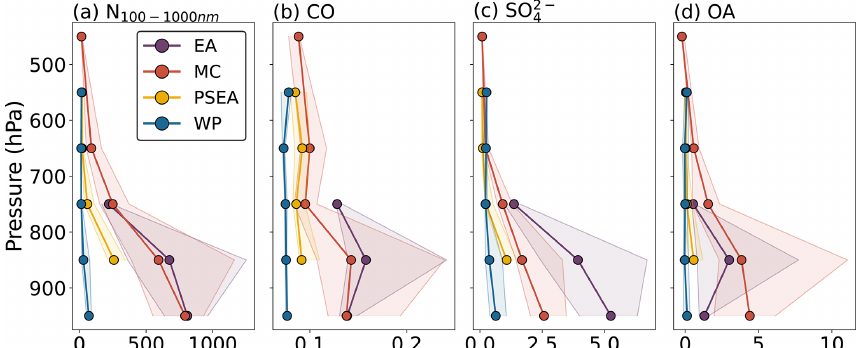
Figure 6. Vertical median profiles of composition for peninsular Southeast Asia (PSEA), the Maritime Continent (MC), East Asia (EA), and the West Pacific (WP). (a) N 100 − 1000nm (cm − 3 ), (b) CO (ppm), (c) SO 2 − (µgm − 3 ), (d) OA (µgm − 3 ). Left and right sides of shaded areas 4 refer to 25th and 75th percentiles, respectively. Table 3. Comparisons of boundary layer (BL; < 2km) and free troposphere (FT; > 2km) mean values across source regions. Uncertainty values are presented as 1 SD. Bold values denote when significant statistical differences are found ( p < 0 . 05). Corresponding p values are provided in Table S2. The EA FT column was left blank due to the infrequent sampling of EA air in the FT. AMS total is provided minus RF9 for better comparison to BC (no RF9 SP2 data). Statistics exclude RF18 (local pollution flight). EA MC PSEA WP BL FT